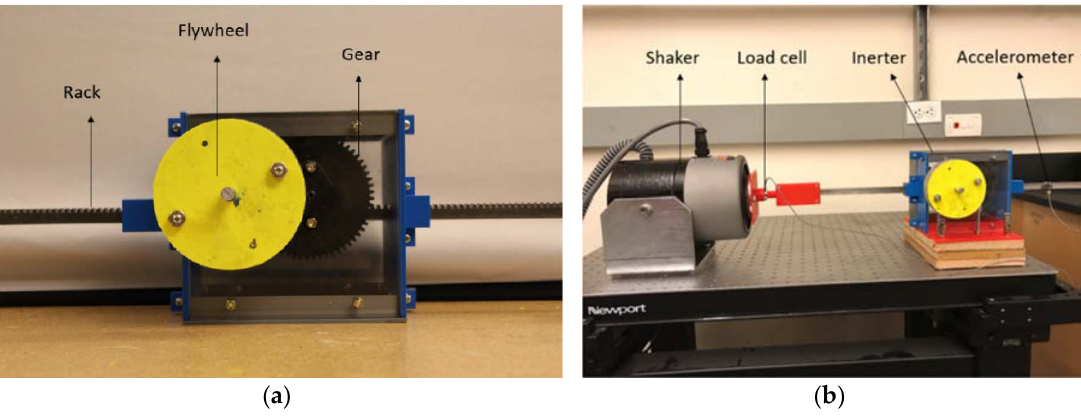
Figure 5. ( a ) The rack ‐ and ‐ pinion inerter and ( b ) its experimental setup. Table 3. Key components of the rack ‐ and ‐ pinion inerter. COTS: commercial off the shelf.